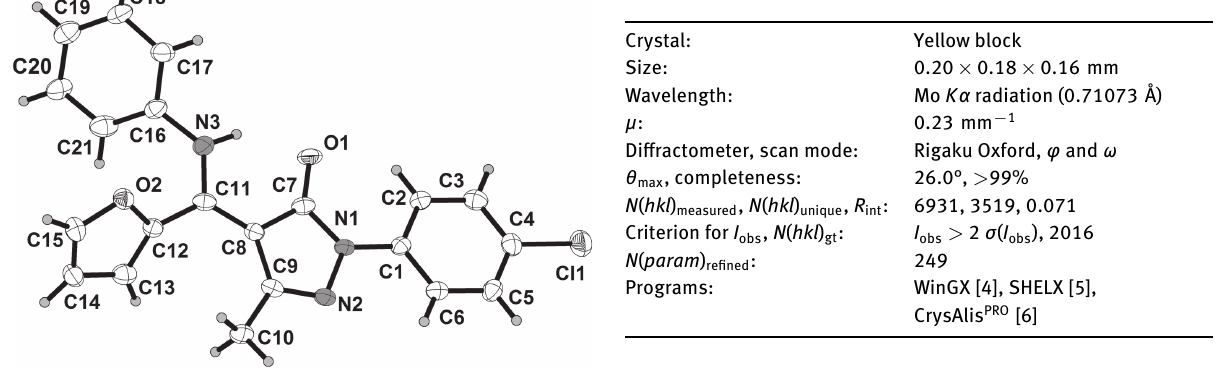
Table 1: Data collection and handling.